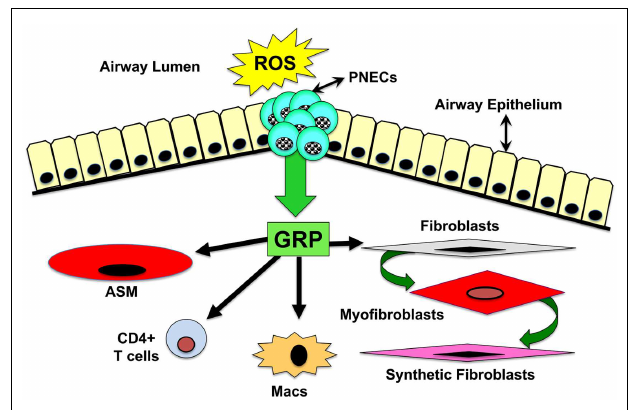
FIGURE 2 | Schematic drawing of overall hypothesis: mechanisms by which GRP mediates lung injury and fibrosis . Environmental exposures generating ROS trigger PNECs to secrete GRP, which acts directly on target cells bearing GRPR or NMBR.These target cells include airway smooth muscle cells, macrophages, CD4 + T cells, neutrophils, endothelial cells, and pulmonary fibroblasts. Secondary effects could be due to GRP-induced cell differentiation or secretion of cytokines by macrophages andT